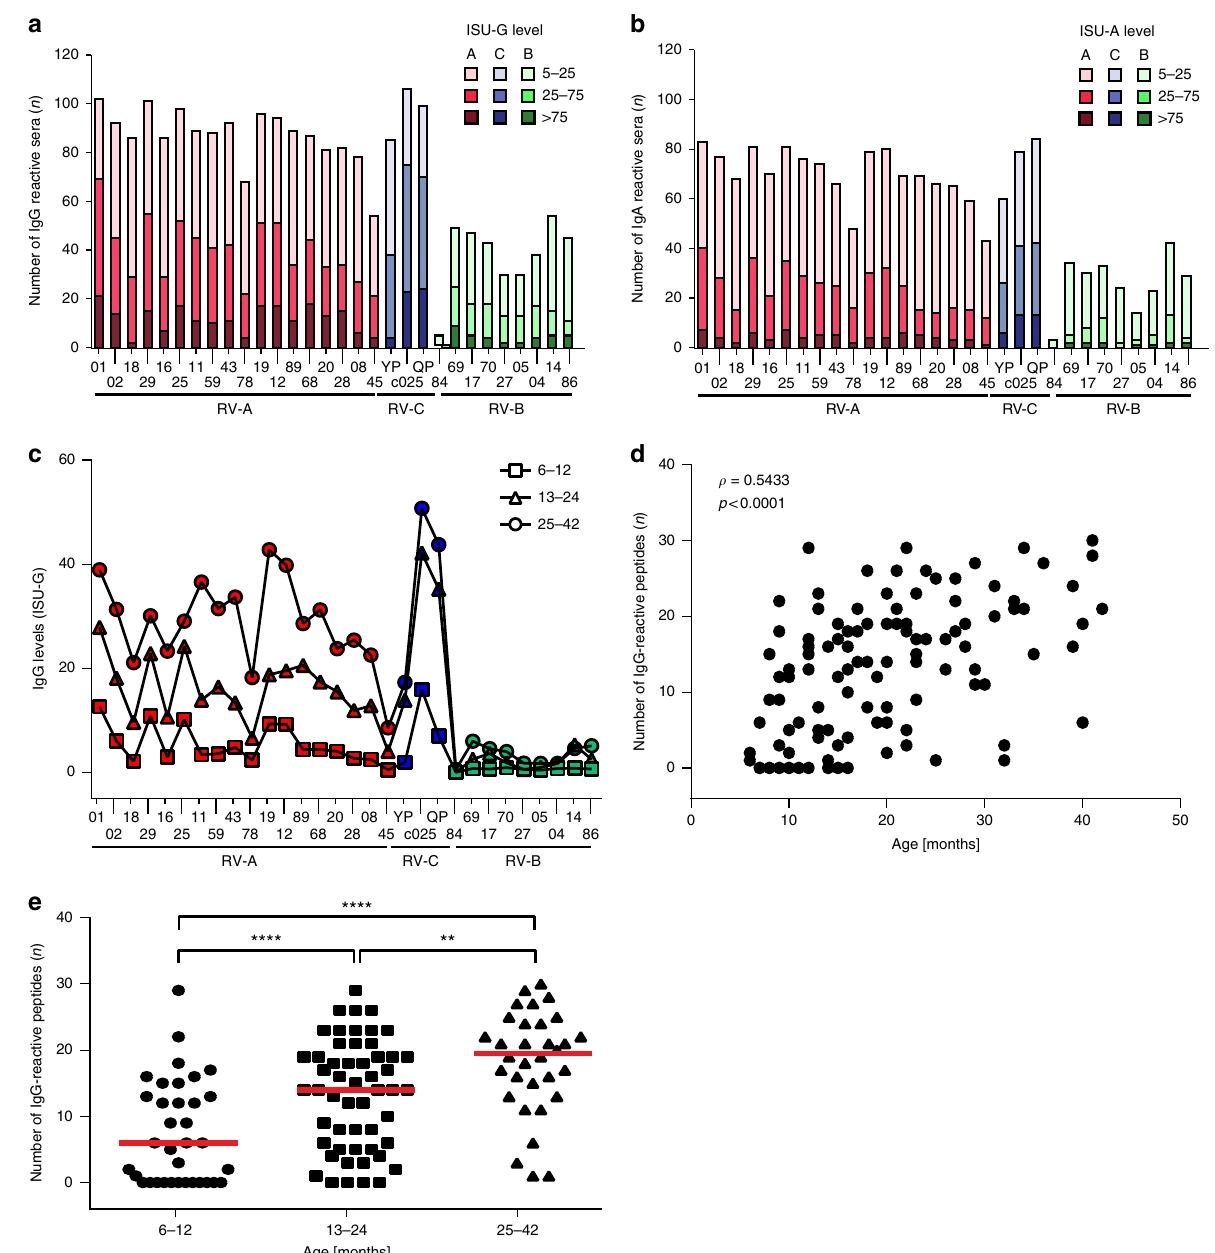
Fig. 2 RV-speci fi c antibody responses in sera from children with acute wheeze. Frequencies and levels of a IgG and b IgA responses ( y -axes: n , number of reactive sera) to the N-terminal VP1 peptides from 30 RV strains (Supplementary Tables 2 and 4) ( x -axes: red: RV-A species; green: RV-B species; blue: RV-C species). Antibody levels are color-coded and expressed as ISAC standardized units, ISU-G and ISU-A, respectively. c Median IgG levels ( y -axis: ISU- G) to VP1 peptides ( x -axis) in children grouped according to age (6 – 12 months: squares; 13 – 24 months: triangles; 25 – 42: circles). d Spearman ’ s rank correlation between the number of IgG-reactive peptides ( n , y -axis; median IgG >15 ISU) and age ( x -axis: months). Correlation coef fi cient ( ρ ) and p -value are shown. e Comparison of the number of IgG-reactive VP1 peptides ( n , y -axis; median IgG >15 ISU) in children according to age ( x -axis). Horizontal lines indicate medians. Statistically signi fi cant differences between groups are indicated (** p < 0.01, **** p < 0.0001) (Mann – Whitney U-